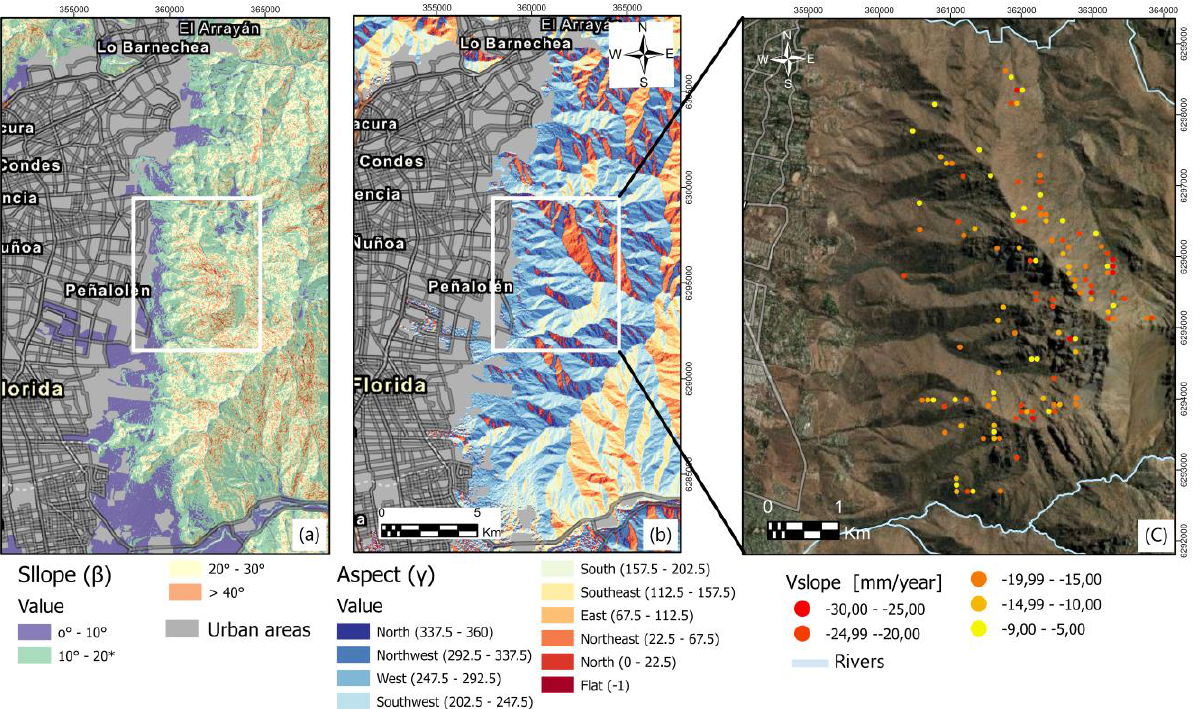
Figure 9. ( a ) Slope map with the highest values in pink color, ( b ) Aspect map indicating the values of the direction of the slopes, with ALOS DEM 30 mts used as background, and ( c ) Velocities along steepest slope (Vslope map), with Maxar image (source Esri) used as background.